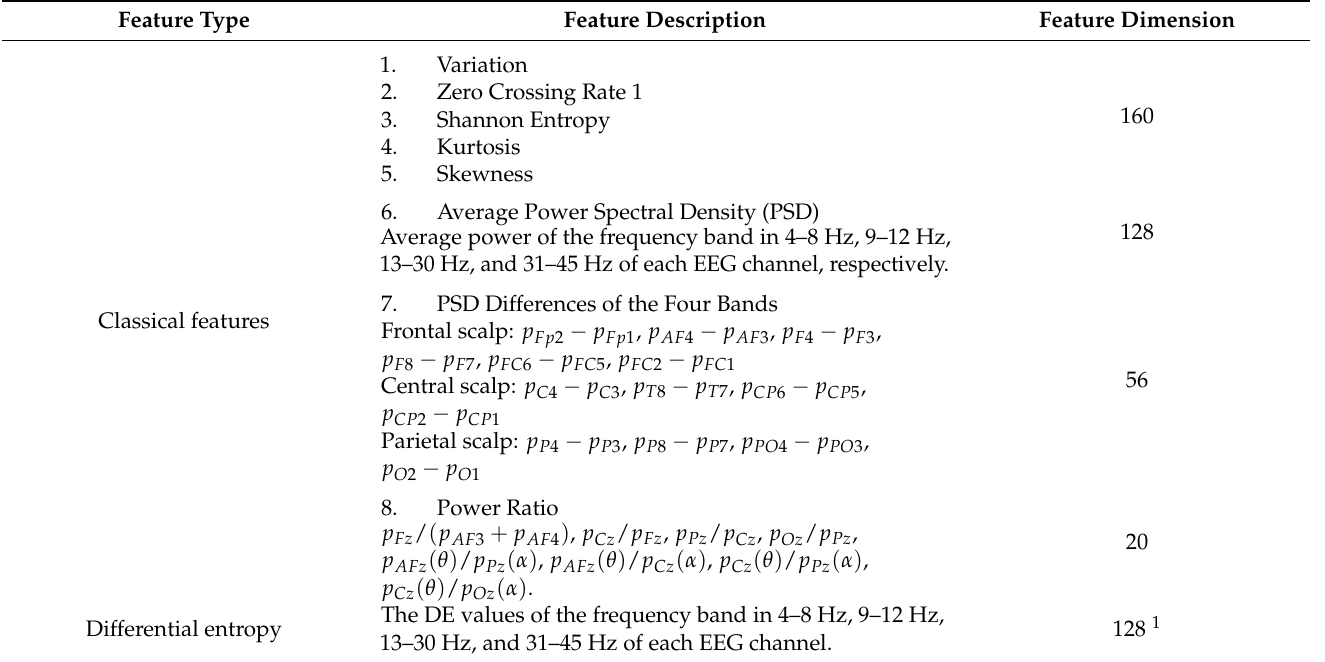
Table 2. Descriptions of the extracted EEG